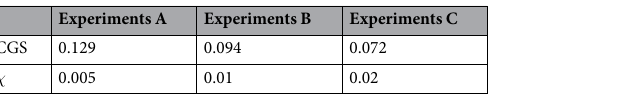
Experiments A Experiments B